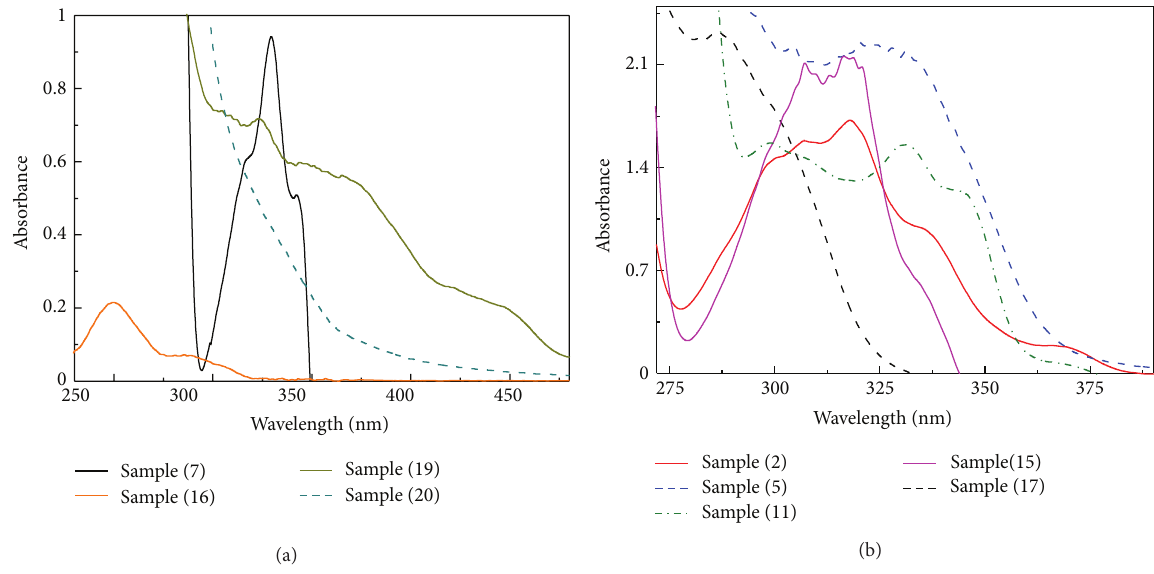
Figure 1: UV/V is absorption spectra of (a) samples 7 , 16 , 19 , 20 , and (b) samples 2 , 5 , 11 , 15 , 16 , and 17 (all samples are kept at 0.02 M).